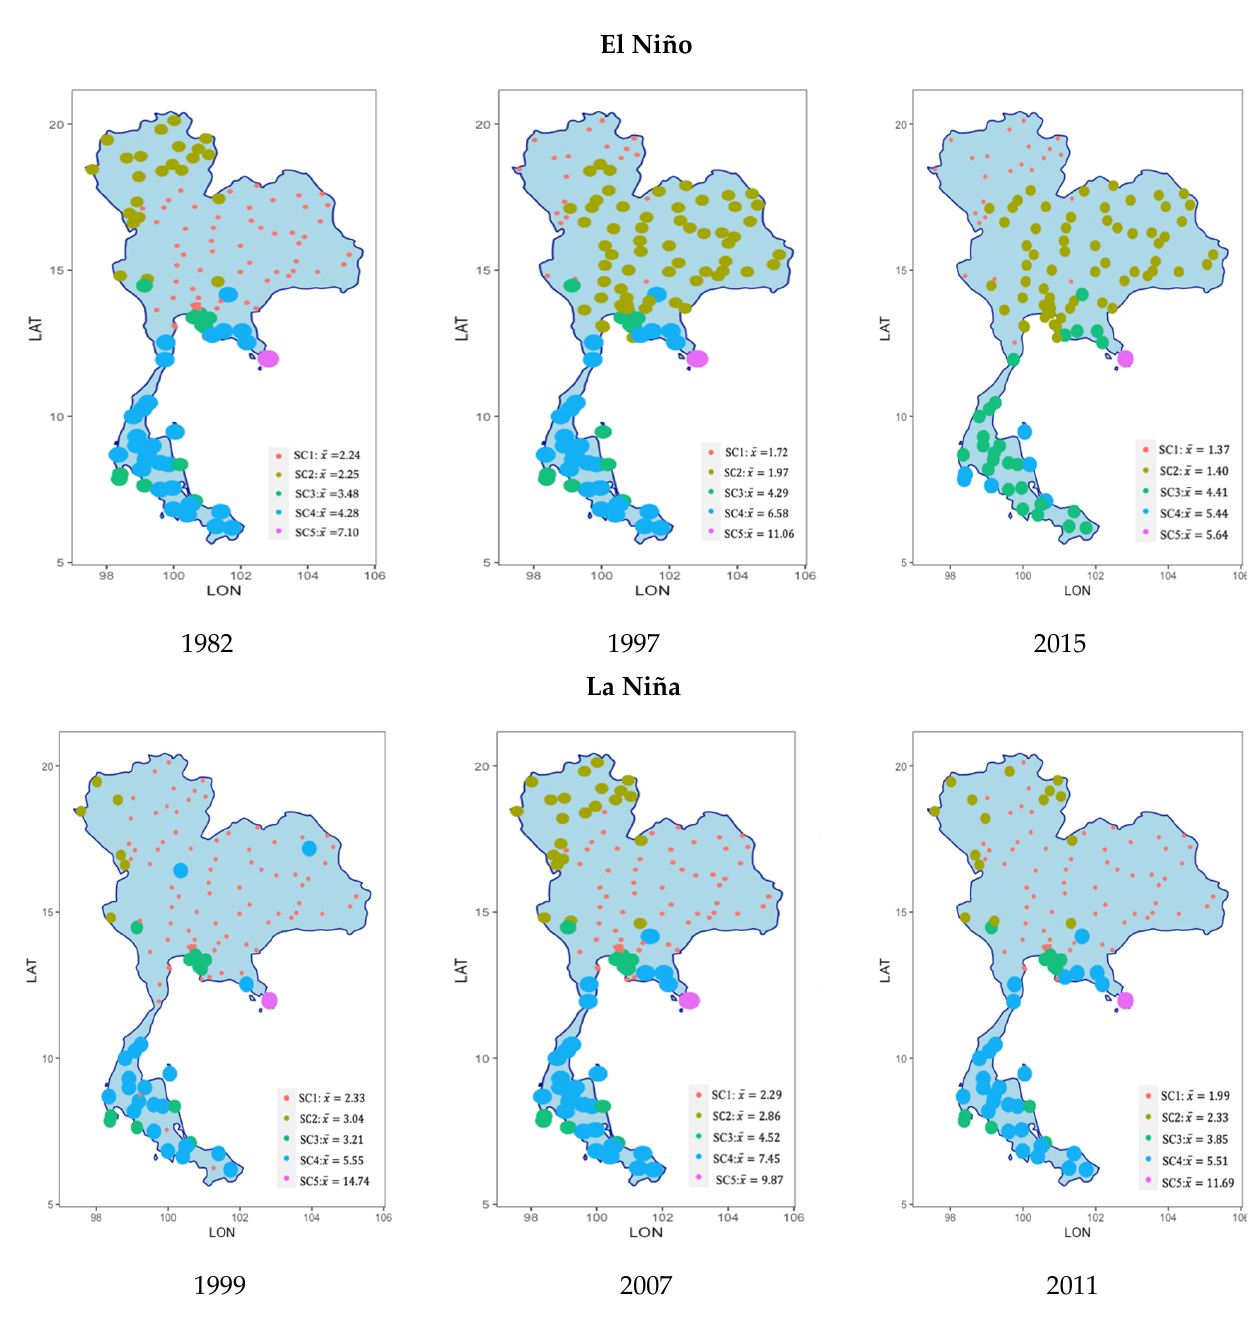
Figure 6. Spatial cluster analysis (SC1–SC5) for the 124 Thai meteorological stations on a map by ENSO events and years ( x is monthly rainfall